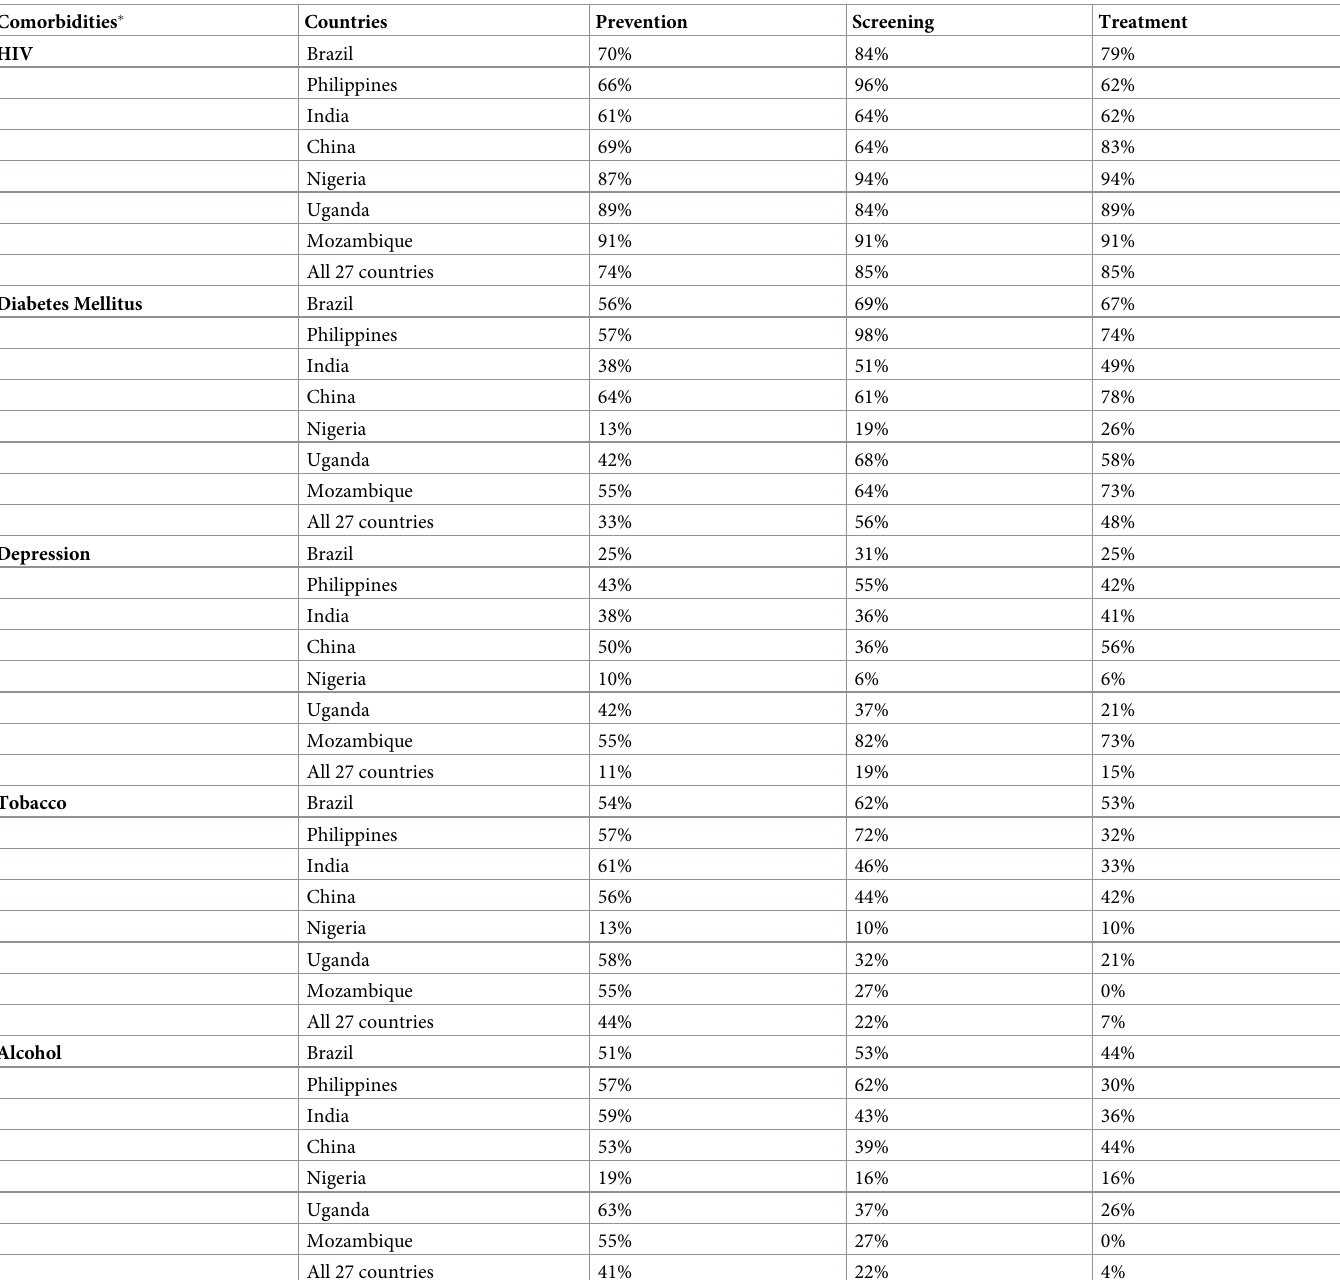
Table 2. Proportion of countries where majority ( > 50%) thought that specific comorbidities are included within TB policy documents. Comorbidities � Countries HIV